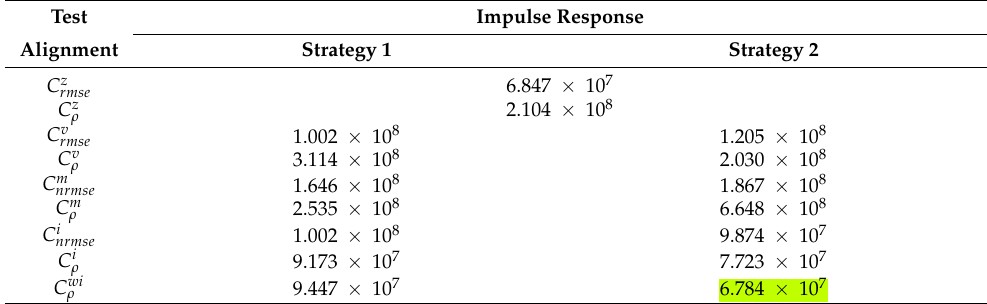
Table 6. RMSE Metrics to Cross-Validate the Performance of the Parameter Estimation Results presented in Tables 3–5 using an Impulse Response